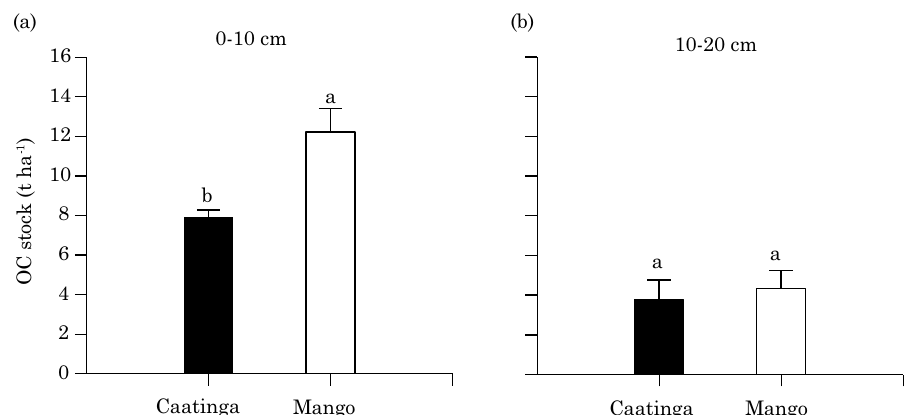
Figure 2. Organic carbon (OC) stocks in the 0-10 and 10-20 cm layers of soils under the growth of irrigated mango and native caatinga . Columns designated with the same letter do not differ by the Student t test (α = 5 %). The vertical deviation bars represent the standard deviation of the